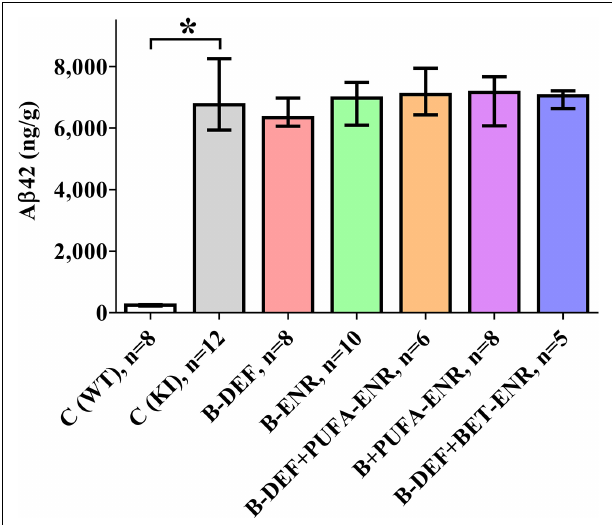
FIGURE 8 | Total A β 42 level (GuHCl-soluble) per gram wet brain tissue in a 100 mg cross-section; age 67–68 weeks; median ± IQR; outliers beyond 3-fold IQR removed; p < 0.05 (Mann-Whitney- U -test) considered statistically significant